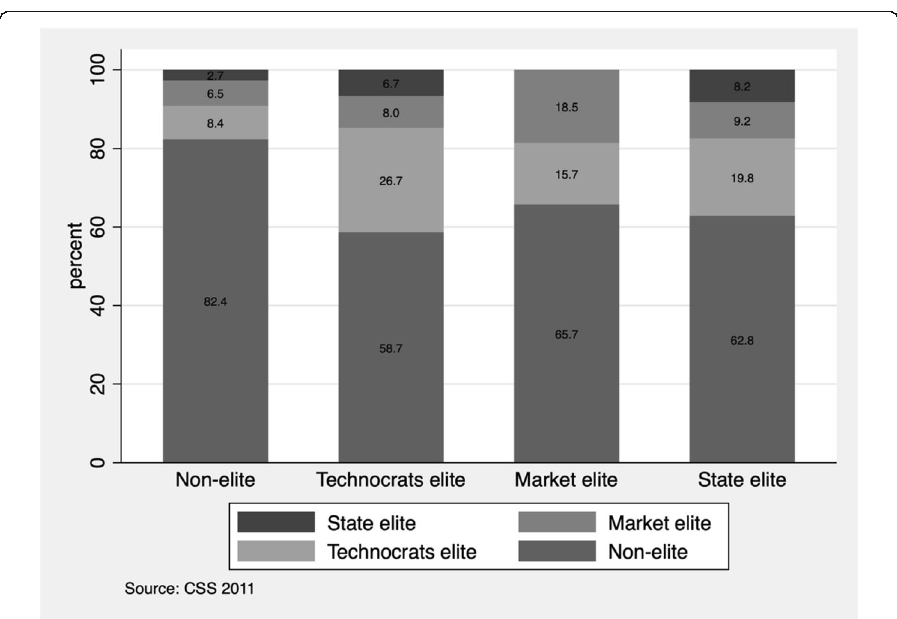
Fig. 2 Distribution of respondent ’ s social class by family